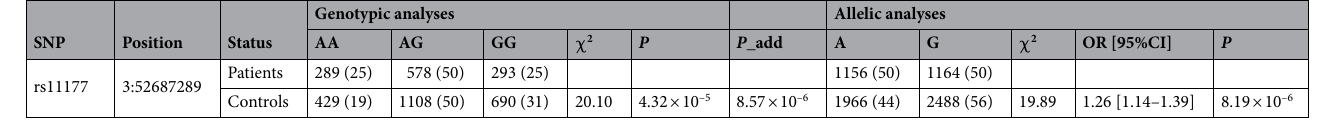
Table 2. Significant association signal obtained from SNP rs11177.